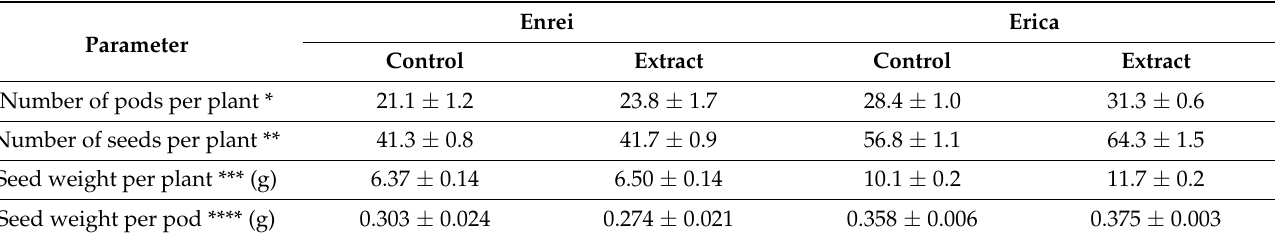
Table 3. Agronomic traits (mean ±